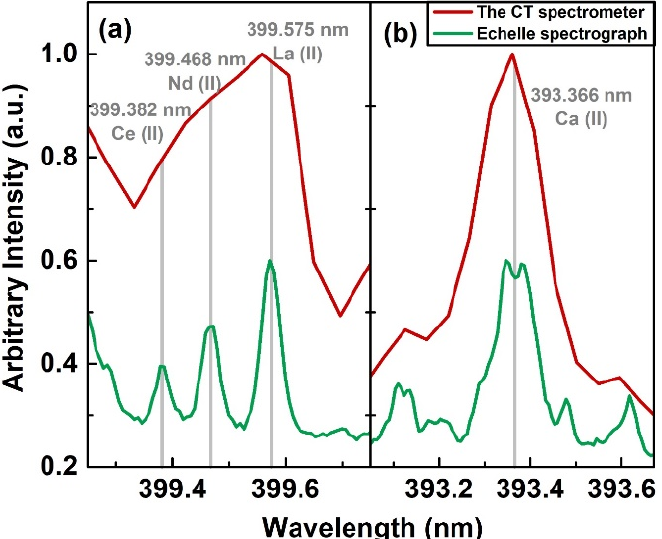
Figure 3. ( a ) Comparison of spectral resolution of the CT spectrometer and echelle spectrograph for lines of three major REEs; ( b ) apparent absence and clear observation of self-reversal for strong Ca (II) 393.366 nm line by the CT spectrometer and echelle spectrograph, respectively.